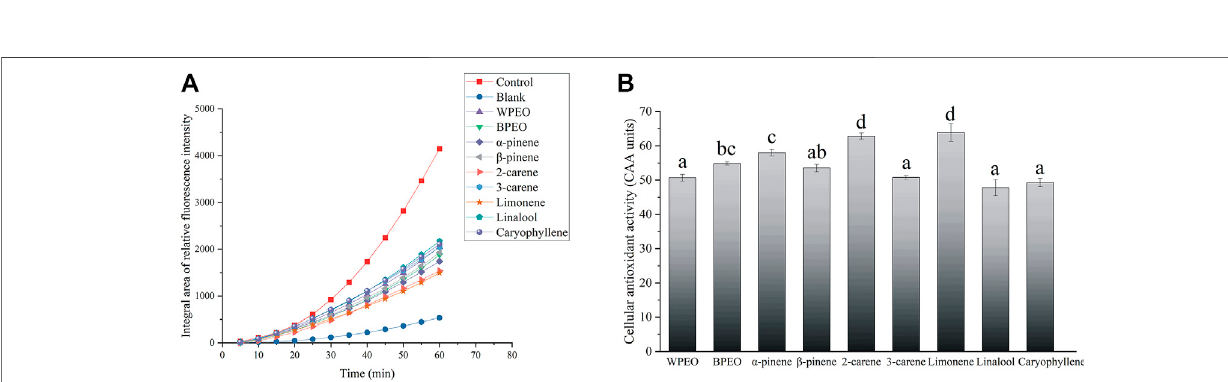
Figure 2A . After 1-h cultivation, the relative fl uorescence intensity in the control group stimulated by H 2 O 2 was nearly eight times that of the blank group without the H 2 O 2 stimulation.